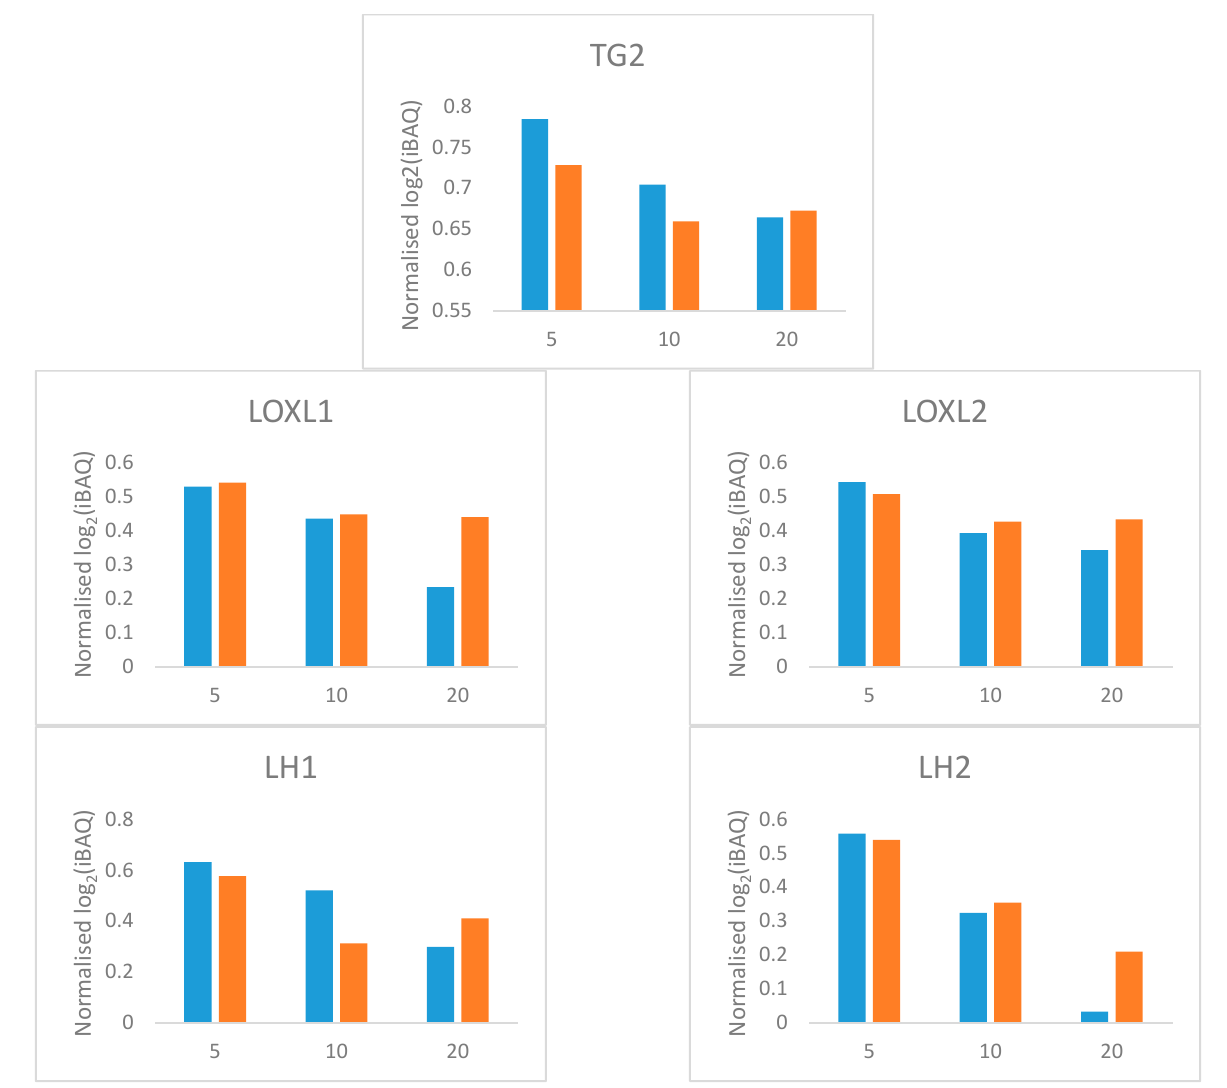
Figure A2. Scale-to-interval normalised protein levels obtained from the time course proteomics experiment with the TGF β -1 stimulation of dermal fibroblasts ( n = 1). The blue and the orange bars represent the protein amounts in the control and in the TGF β treated samples, respectively.